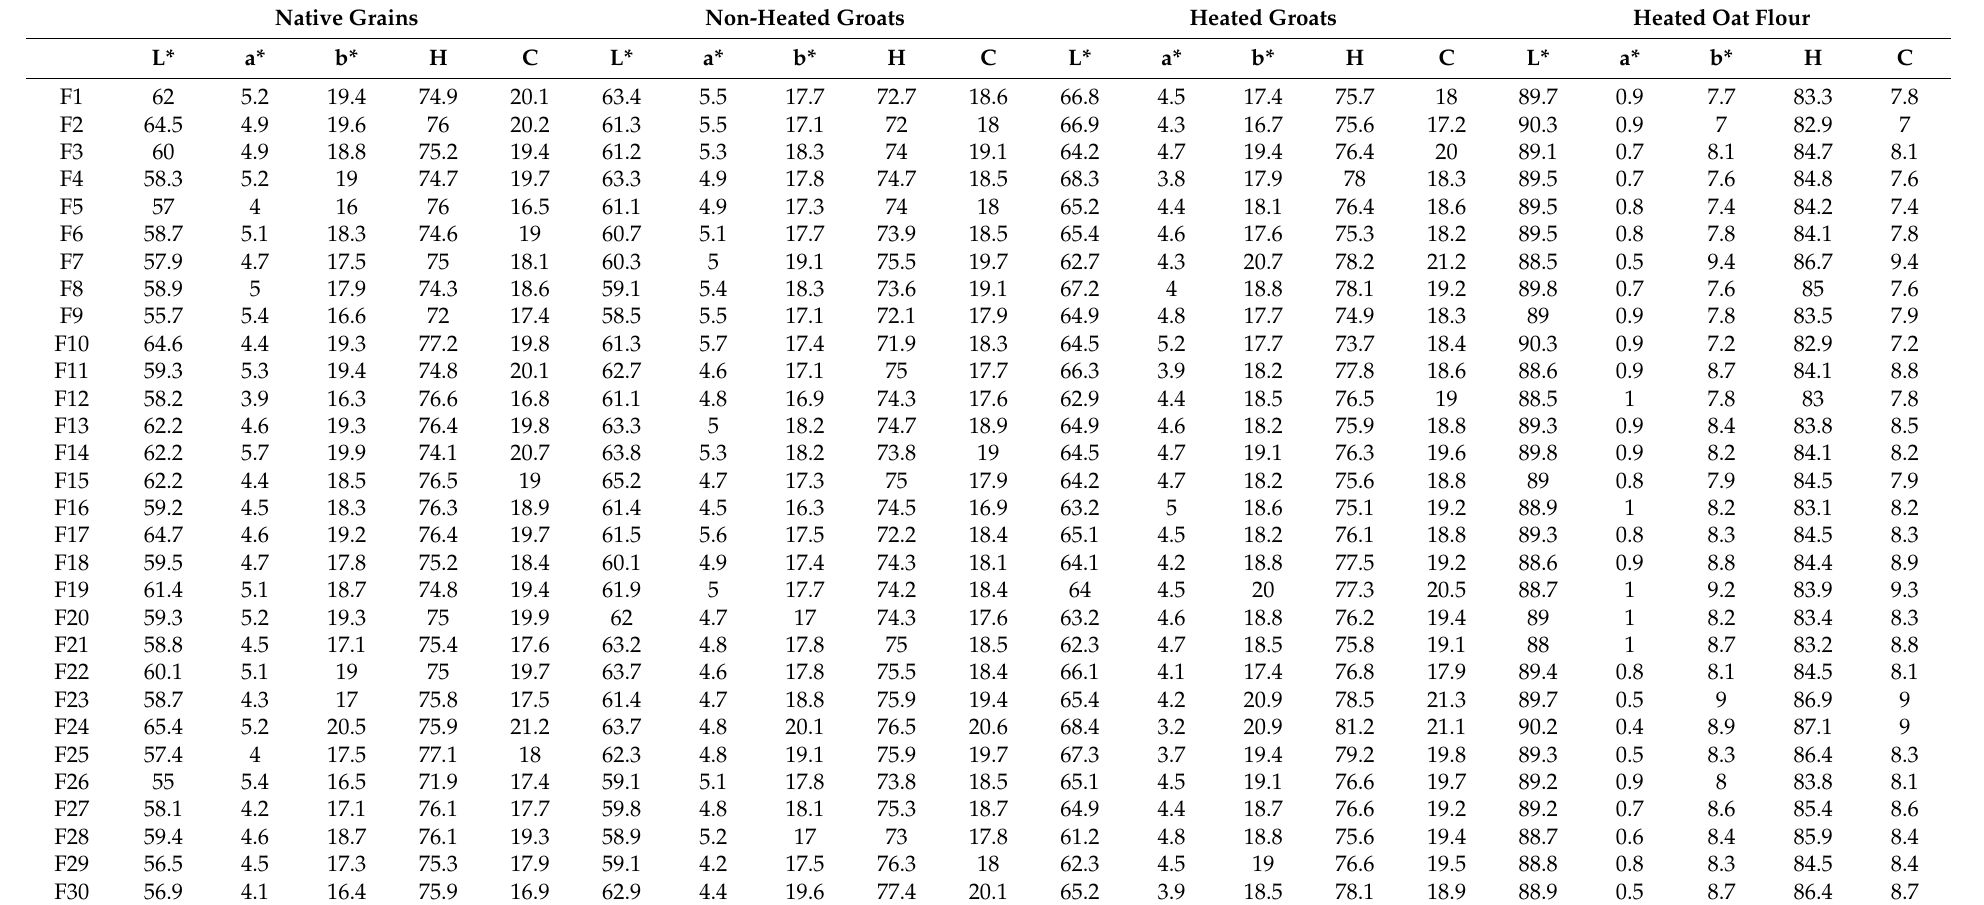
Table A2. Color properties of oat grains, non-heated groats, heat-treated groats and heated oat flour. The grain color is presented as the L*, a*, b* color spacer defined by the International Commission of Illumination (CIE). H, hue; C, chroma. The standard deviations were maximums of 2.9, 1.0, 2.0, 2.7 and 2.1 in L*, a*, b*, hue and chroma, respectively. Native